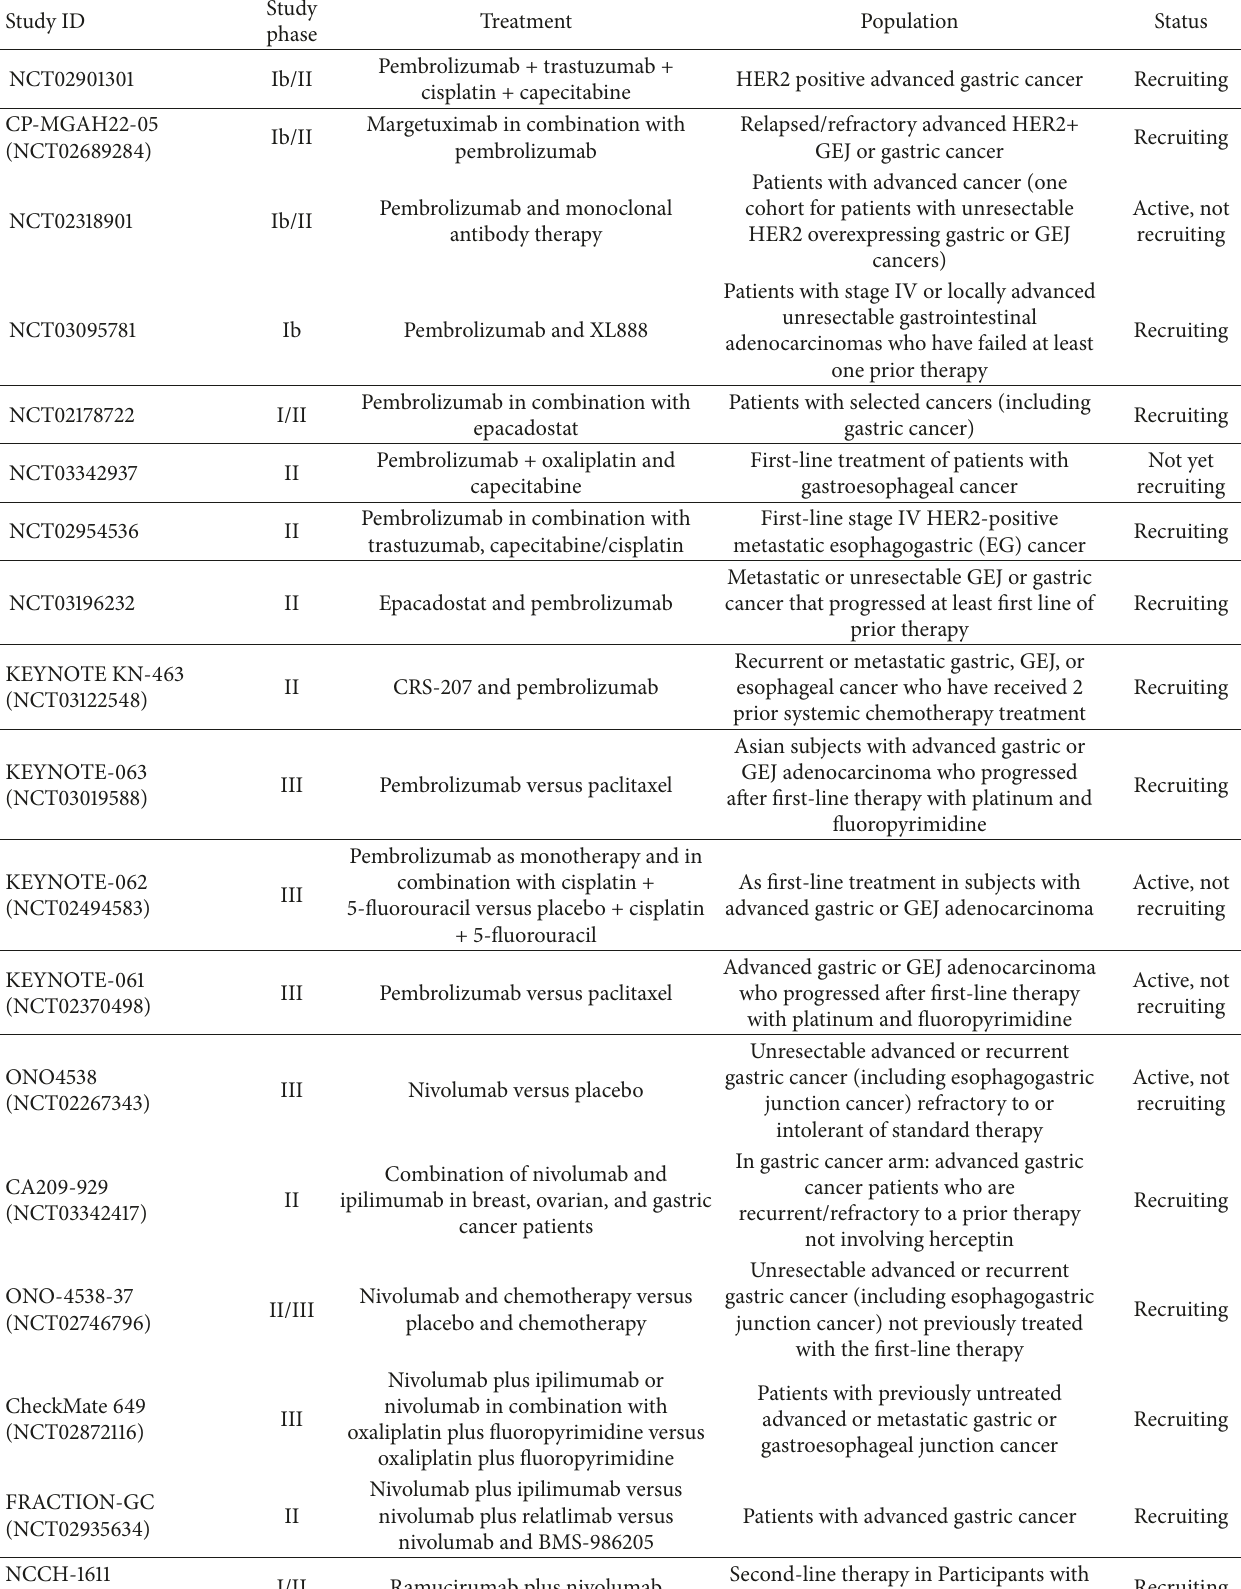
Table 1: Ongoing trials with anti-PD1 in advanced gastric